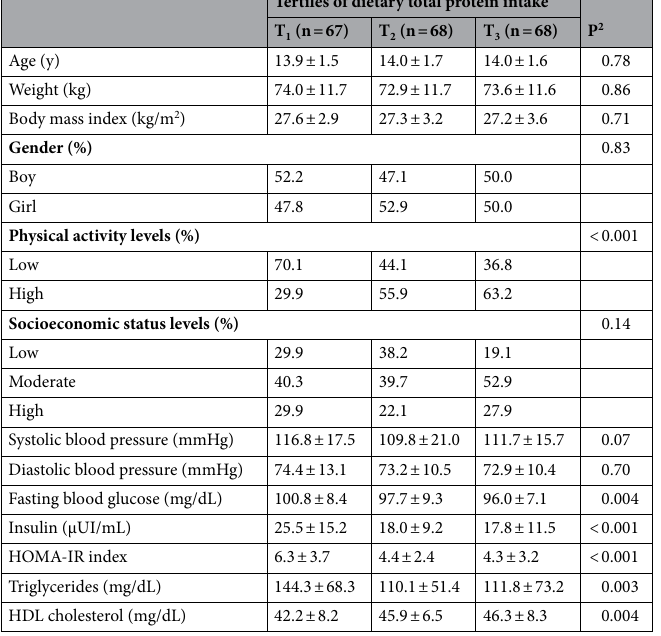
Table 1. General characteristics of study participants across tertiles of dietary total protein intake (n = 203) 1 . 1 All values are means ± standard deviation (SD), unless indicated. 2 Obtained from ANOVA for continuous variables and chi-square test for categorical